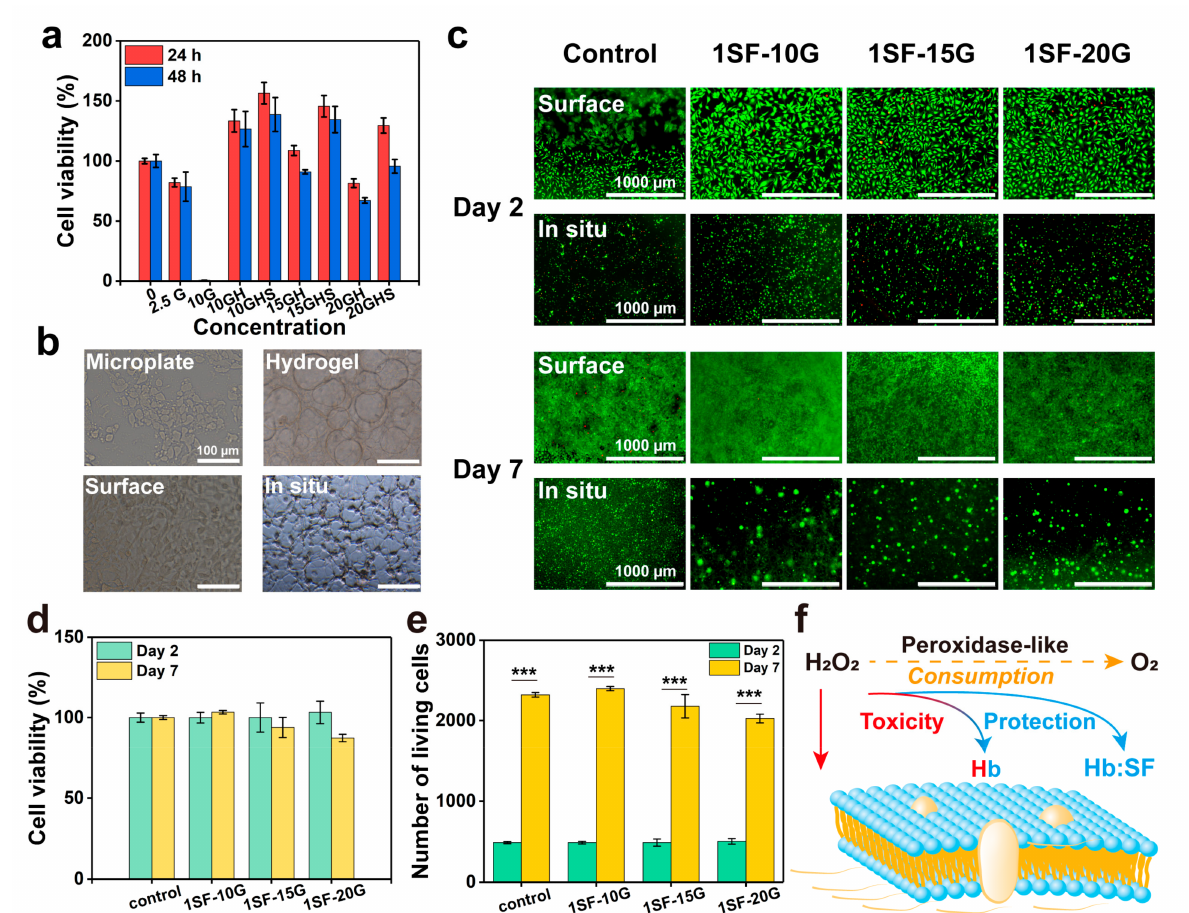
Figure 6. Survival and proliferation of NIH 3T3 cells. ( a ) Cell viability of the SF/glucose/GOx/Hb system in 24 and 48 h. (2.5G: GOx [2.5 mu mL − 1 ], 10G: GOx [10 mu mL − 1 ], 10GH: GOx/Hb [10 mu mL − 1 , 3 mg mL − 1 ], 10GHS: GOx/Hb/SF [10 mu mL − 1 , 3 mg mL − 1 , 1 mg mL − 1 ]). ( b ) Coloured bright field of cells and hydrogel. Scale bars are 100 µ m. ( c ) Cell proliferation of NIH 3T3 cultured on the hydrogel surface and encapsulated in SF hydrogels, live (green) and dead (red) cell staining on hydrogels over a 7-day period, scale bars are 1000 µ m. ( d ) Cell viability and ( e ) number of living cells cultured on the surface of SF hydrogels (days 2 and 7). ( f ) Schematic diagram of cell protection mechanism during the gelation. *** p <